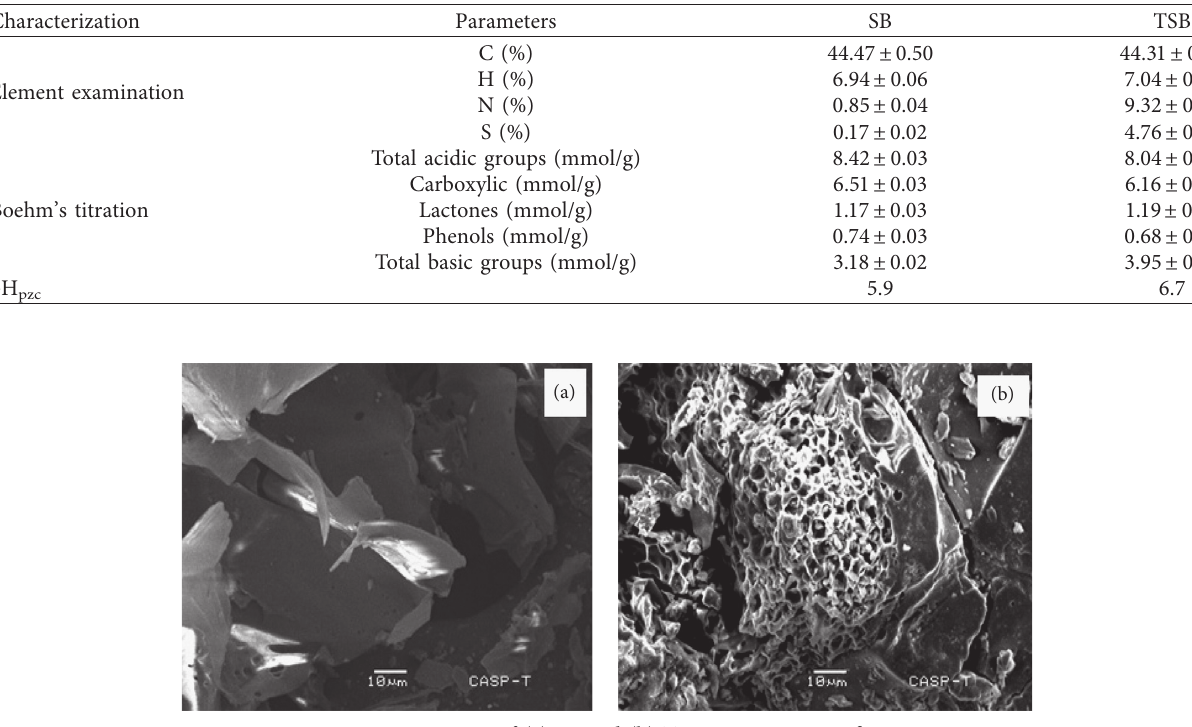
Table 1: Physiochemical analysis of biosorbent samples.